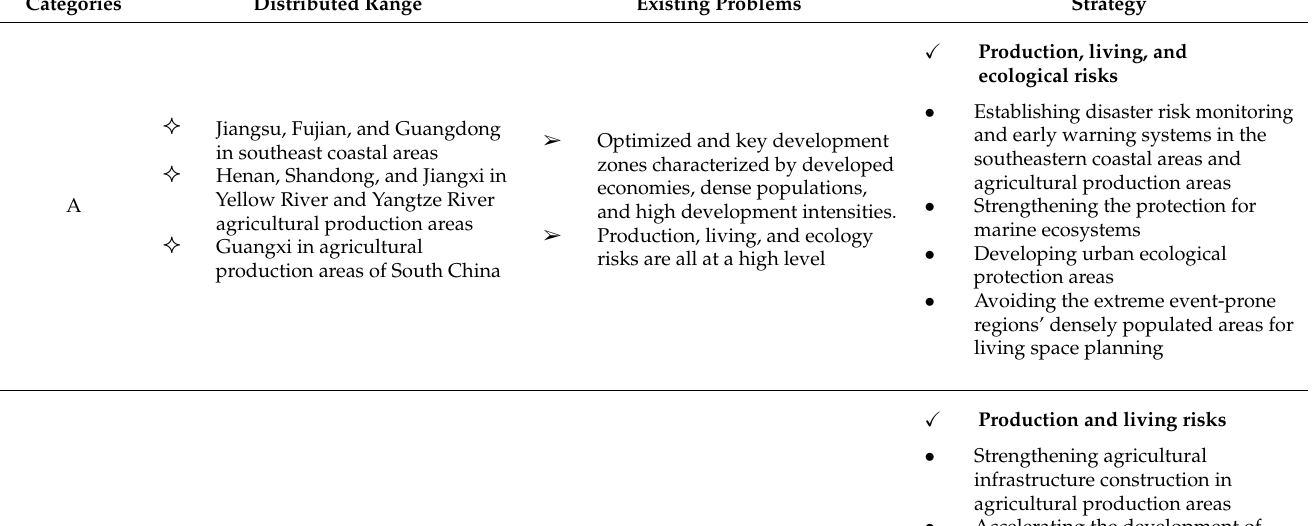
Table 3. Strategy to cope with PLE risk under climate change scenario.